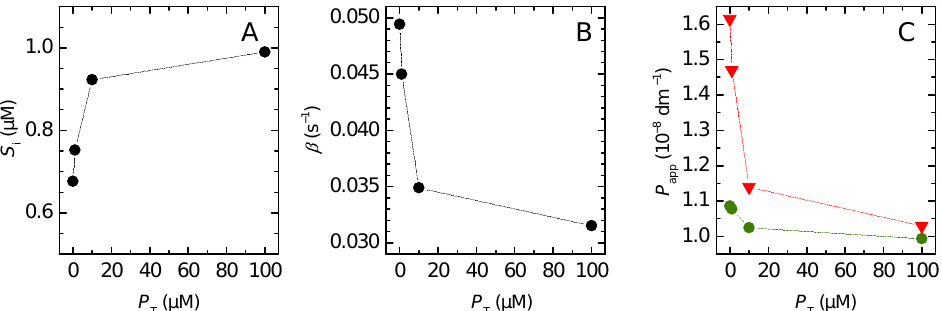
Figure 8. Concentration of solute in the acceptor compartments at equilibrium ( A ), and equilibration characteristic constant ( B ), as a function of the buffer capacity inside the vesicles. ( C ) Apparent permeability coefficient ( P app , circles, and P r app ,triangles) for the various buffer capacities, with the same colour code as in plots A and B. The dotted lines are guides for the